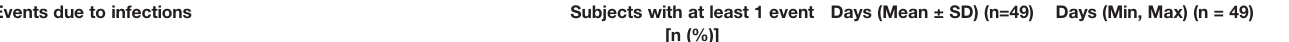
TABLE 5 | Infection-related endpoints, ITT